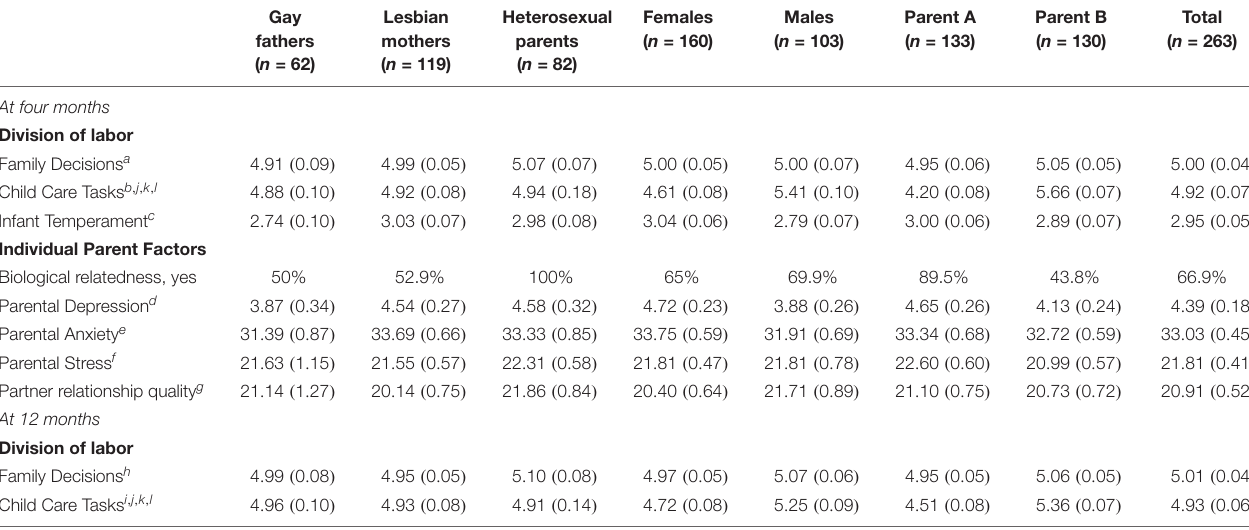
TABLE 2 | Means and standard errors of division of labor, infant temperament, individual parent factors, and partner relationship quality by family type. Gay fathers